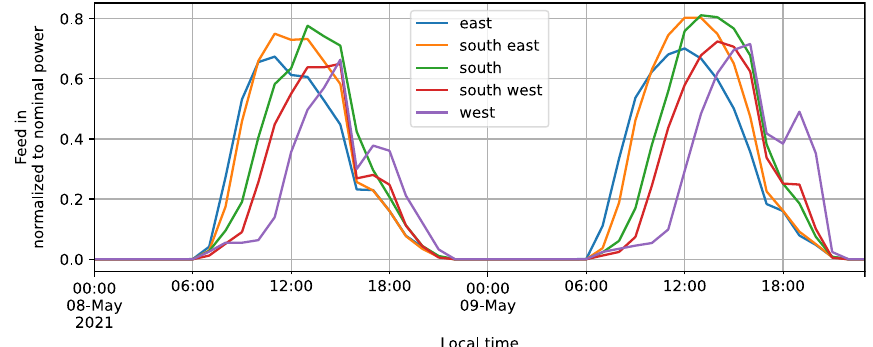
Fig. 8 Plot of exemplary feed-in time series per roof orientation for two days in May